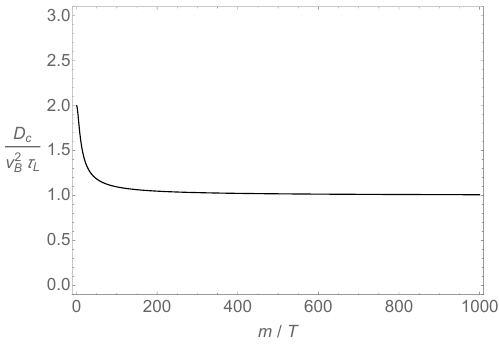
Figure 6 . The lower bound of D c at J = 1 / 3 , which approaches B L = 1 in (4.5) at low T ( m/T (cid:29) 1